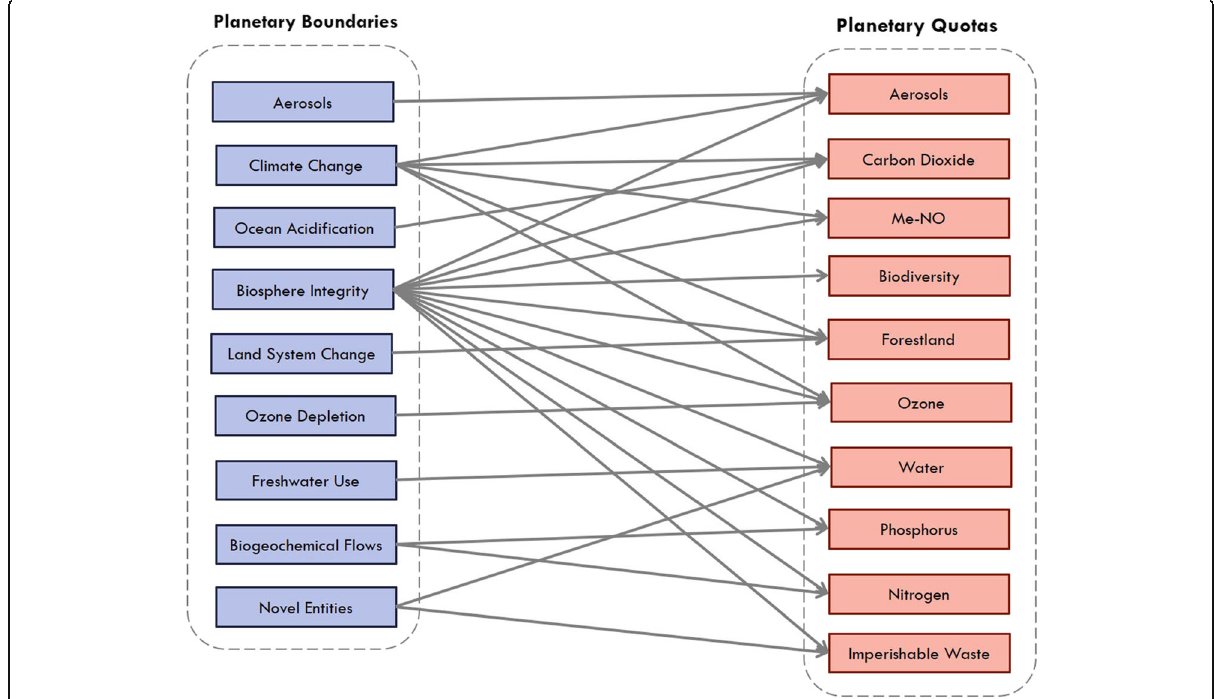
Fig. 6 The relationship between the Planetary Boundaries and Planetary